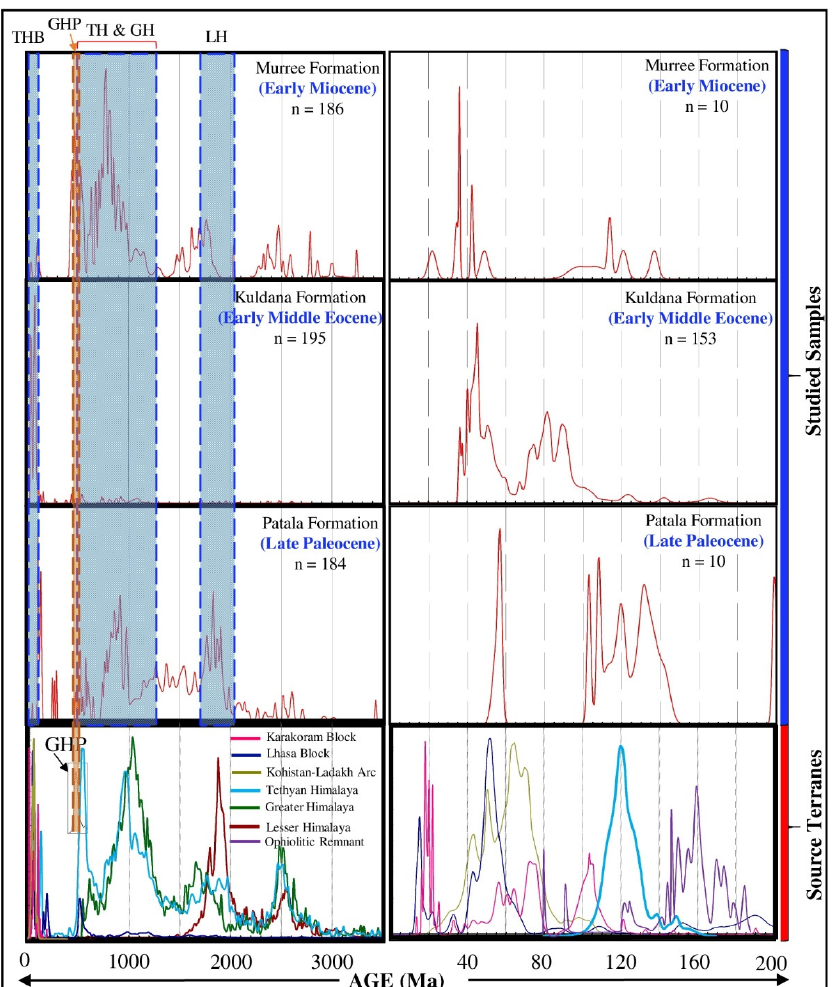
Figure 5. Comparison of composite U-Pb probability density plots Late Paleocene Patala Formation, Early-Middle Eocene Kuldana Formation and Early Miocene Murree Formation with the reference terranes (after Gehrels et al., [45]. The transparent rectangles depict the possible contribution of the various terranes. Where THB = Transhimalayan batholiths, GHP = Greater Himalayan Pluton, TH = Tethyan Himalayan, GH = Greater Himalayan and LH = Lesser Himalaya.